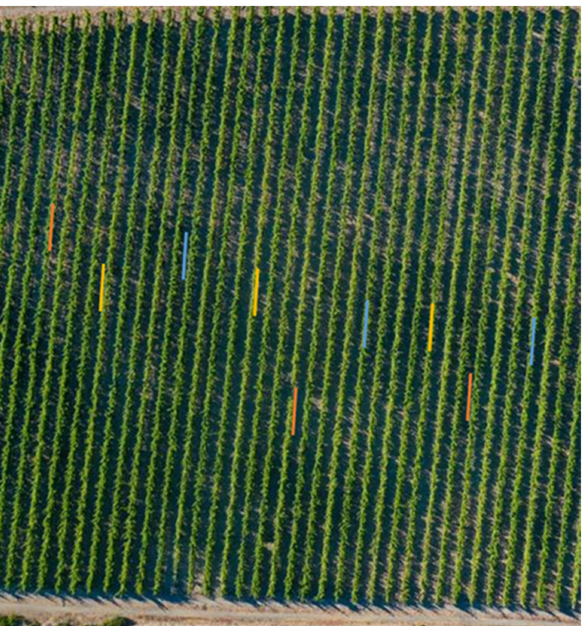
Figure 1. Randomised block design of the vineyard. Orange line— n = 4 vines full irrigation. Yellow line— n = 4 vines deficit irrigation. Blue line— n = 4 vines no